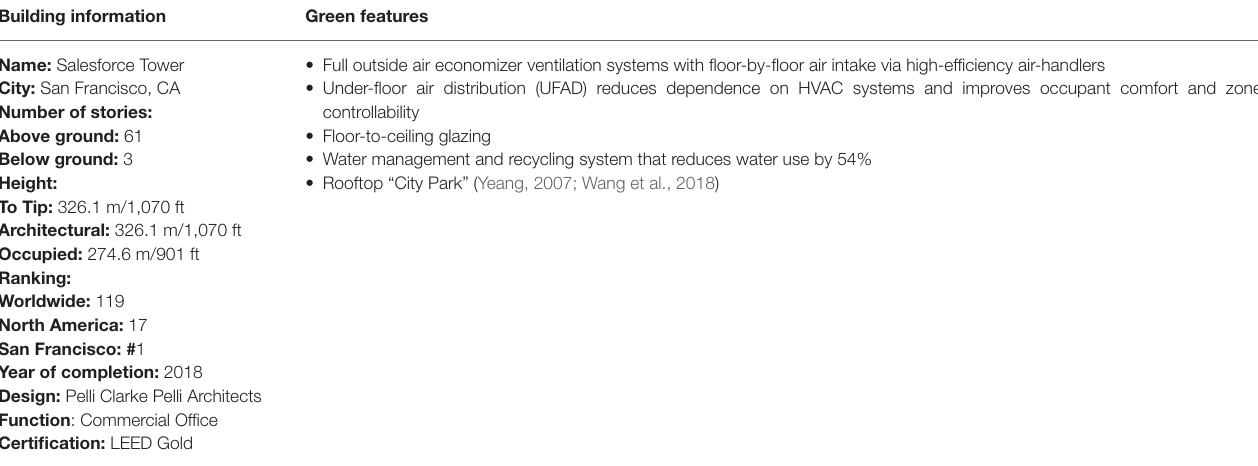
TABLE 5 | Salesforce Tower: Key green features. Building information Green features